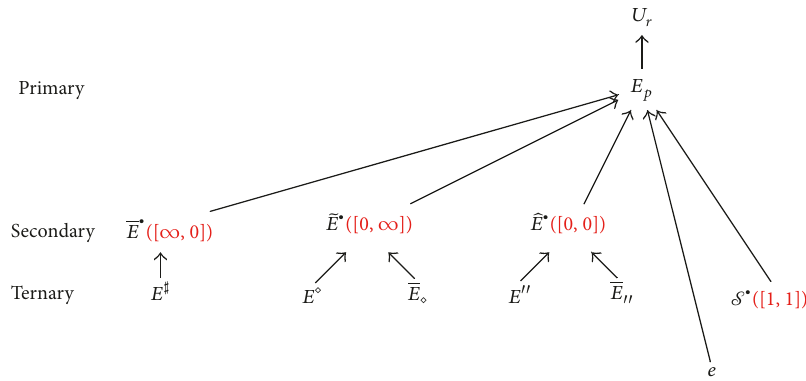
Figure 13: The echoing system E ch.